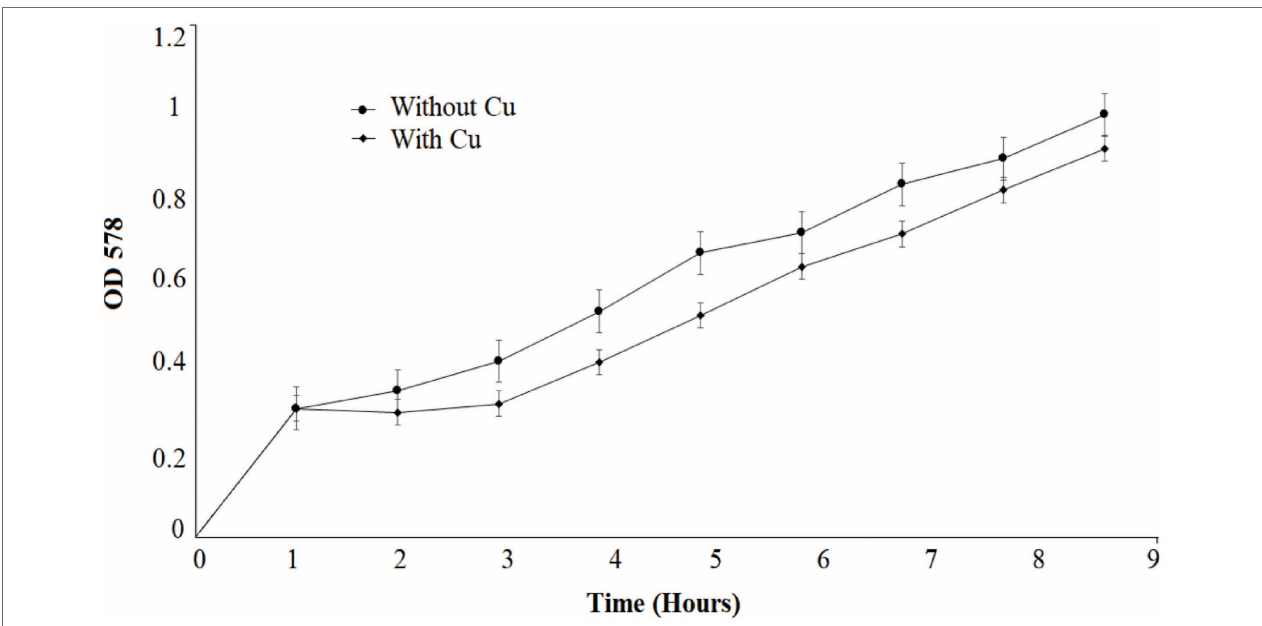
FIGURE 1 | Growth pattern of Bacillus altitudinis MT422188 with Cu (0.1 mm) and control.